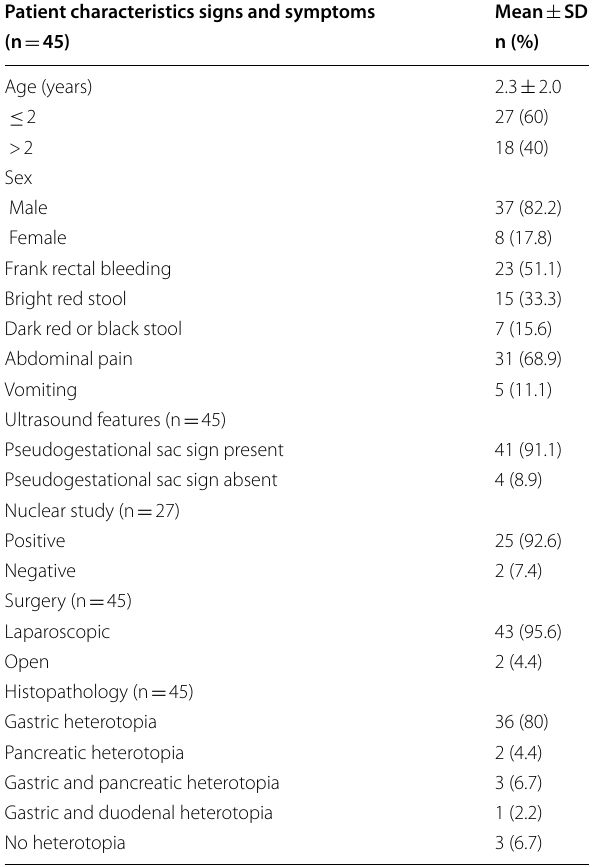
Table 1 Clinical, imaging, operative and histopathological characteristics of 45 children with Meckel’s diverticulum